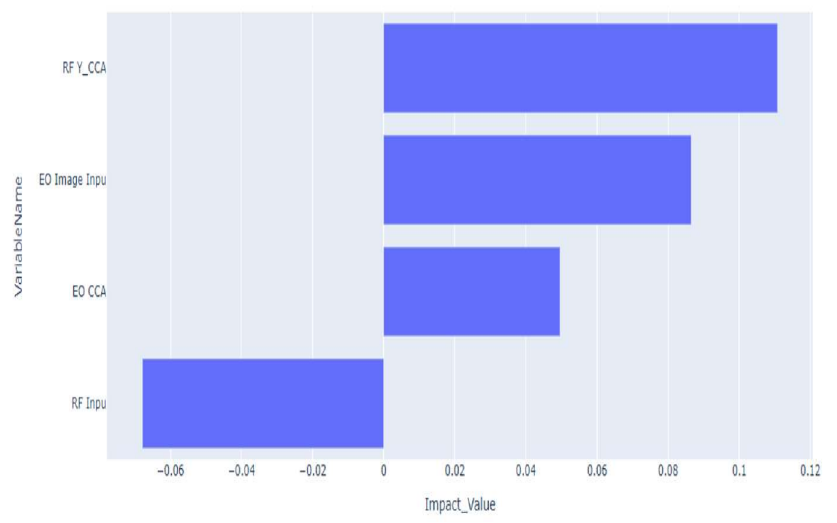
Figure 3. Local impact of data frame attributes for EO, P-RF, and CCA variates for EO and P-RF input